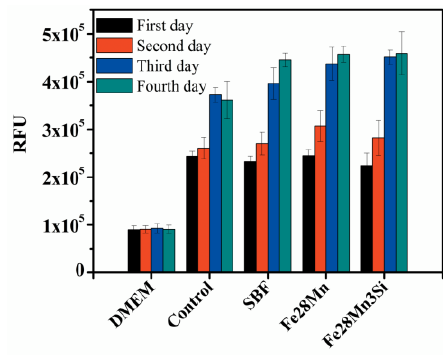
Figure 8. Proliferation of L929 cells in presence of SBF solution containing Fe and Mn ions (Note: Relative fluorescence units are abbreviated as RFU).